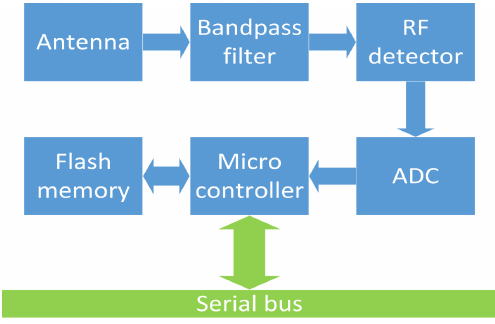
Figure 3. Block diagram of an exposure meter node on the serial bus.